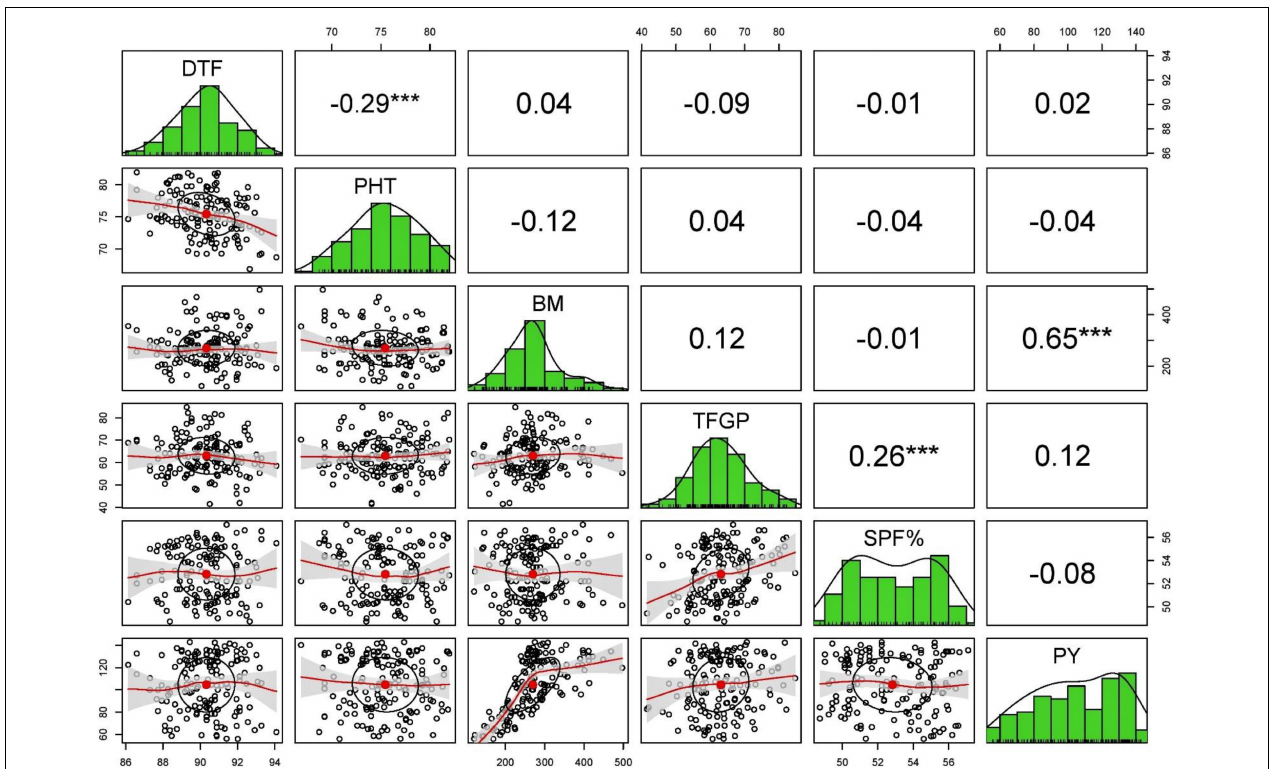
FIGURE 3 | The scatterplot matrix shown here has histograms of the variables in the diagonal, and correlation coefficients in the upper part of the matrix under stress condition of 2015 WS.